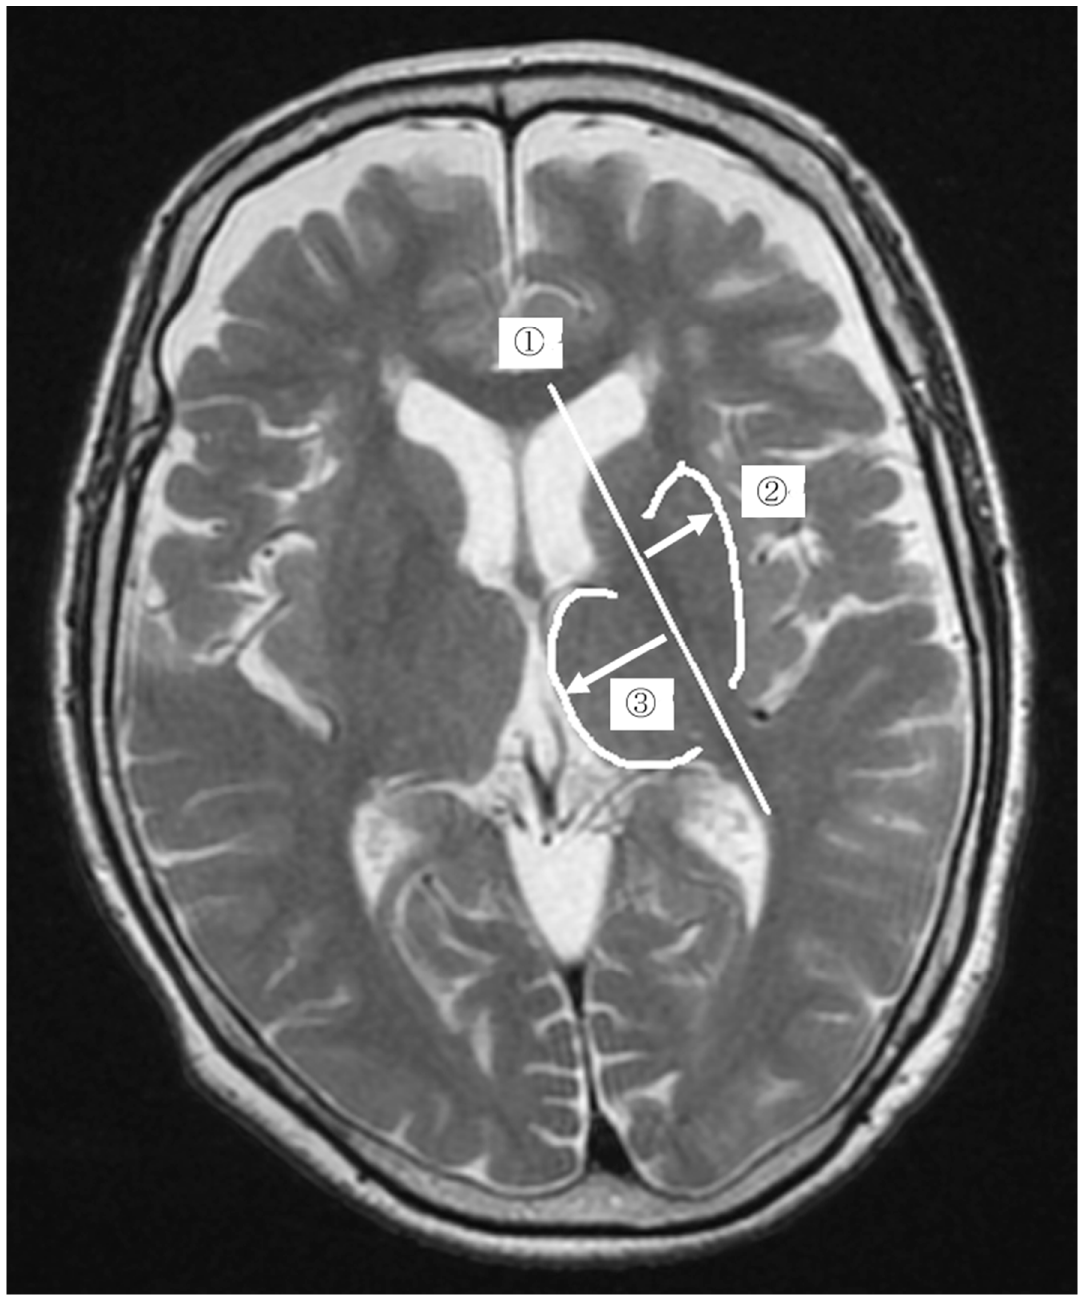
Figure 1. The measurement of the change ratio in the putamen using magnetic resonance images. First, we drew a straight line in the center of the posterior limb of the internal capsule and named it “the posterior limb of the internal capsule line” . Second, we measured the distance from the posterior limb of the internal capsule line to the distal outline of the putamen (Right-pointing white arrow) and named it “putamen distance” . Third, we measured the distance from the posterior limb of the internal capsule line to the distal outline of the thalamus (Left-pointing white arrow) and named it “thalamus distance” . Finally, the ratio of putamen distance to thalamus distance was calculated, and the value was defined as the “change ratio in the putamen”.